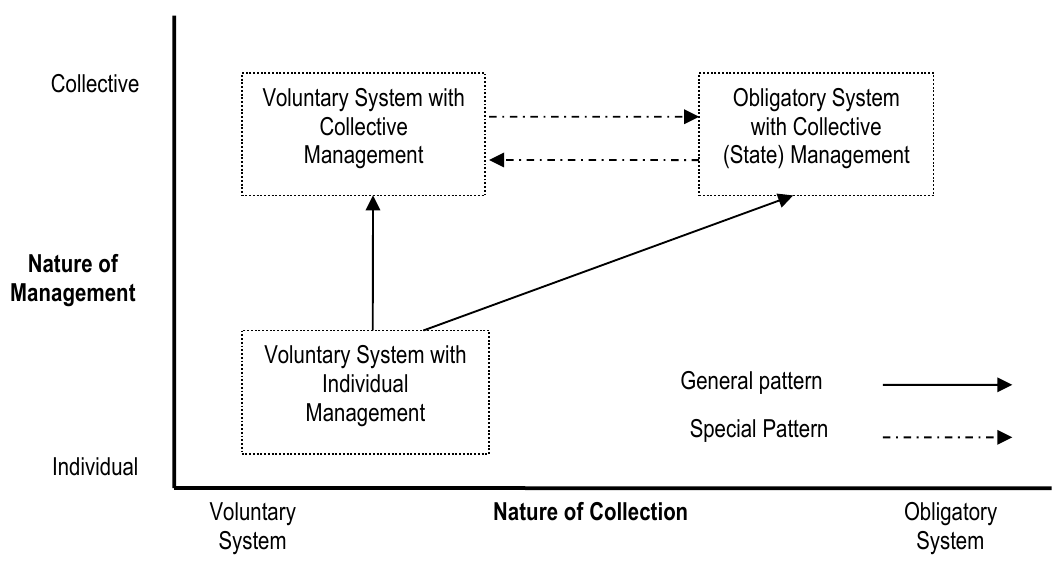
Figure 1. Pattern of Zakāh Management in Contemporary Muslim